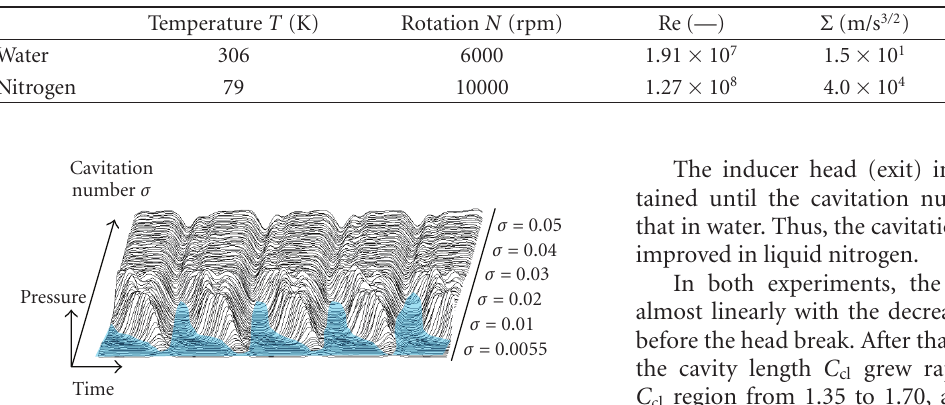
Figure 3: Development view of the inducer showing location of pressure sensors for measurements of pressure rise. Table 1: Comparison of the thermodynamic parameter Σ , Σ ∗ .